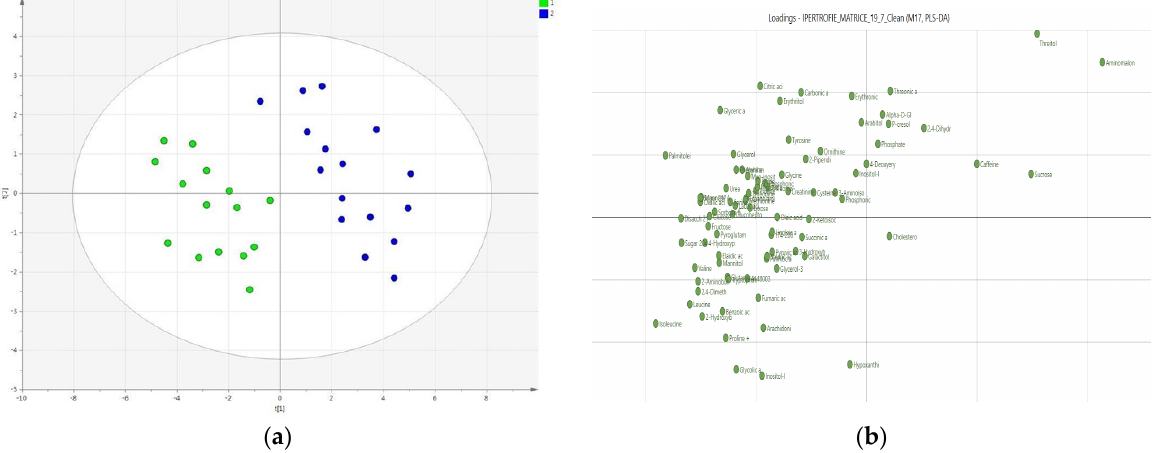
Figure 2. ( a ) Two-groups PLS-DA Scatter Plot of GC-MS spectra of HCM plasma samples: on the left (green dots) OHCM subjects (N = 15), on the right (blue dots) NOHCM subjects (N = 16). The figure shows the clear clustering of the two groups of subjects. ANOVA p -value = 0.01; ( b ) Loading scores of the PLS-DA highlighting the relative abundance of metabolites in OHCM (left inferior corner) in comparison with NOHCM (right superior corner)